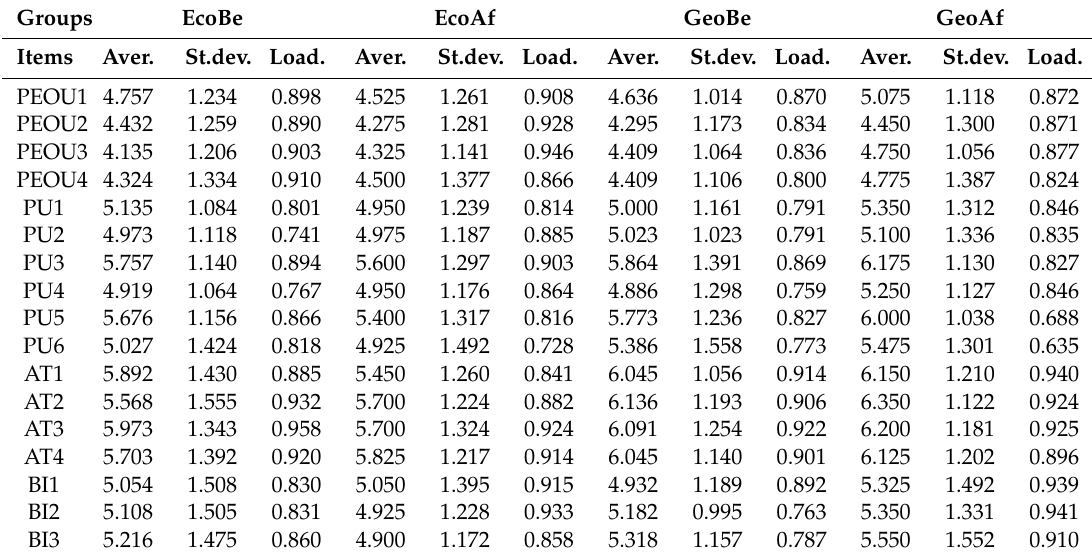
Table 2. Descriptive statistics for four groups.